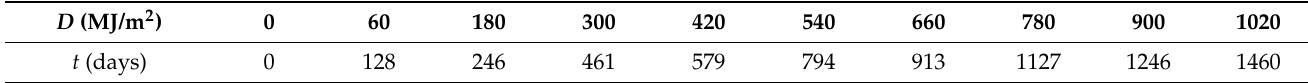
Table 3. Relationship between UV radiation dose ( D ) at 315~400 nm and UV exposure time, t , in